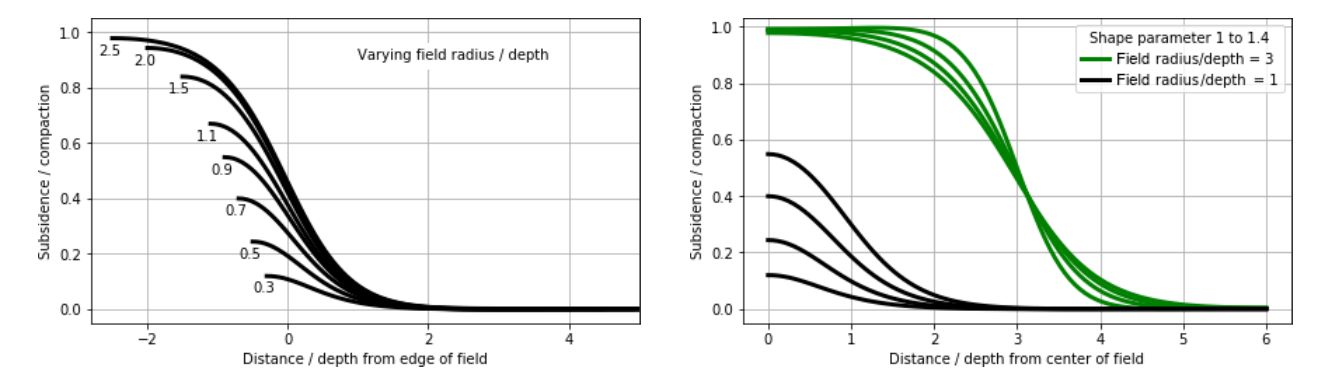
Figure 3. For various relevant field radius / depth ratios (plotted to the left of each line) the subsidence profile between the centre of the resulting bowl (centred at the edge of the field), show how for smaller fields, the maximum subsidence is only a fraction of the compaction at reservoir depth. The subsidence effects are minimal at 1–2 depths distance from the field edge.